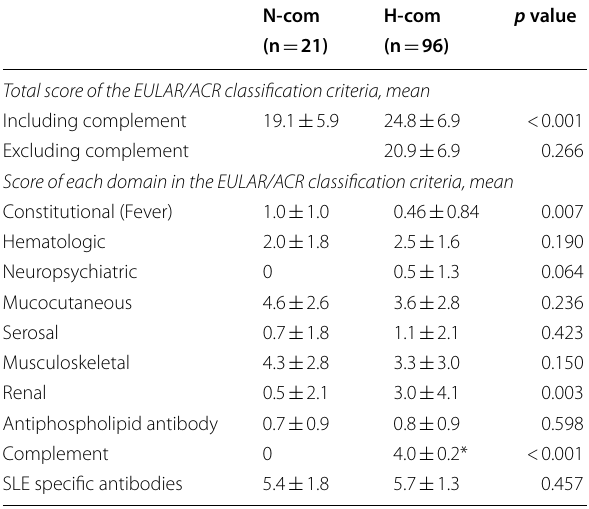
Table 4 Scores in the EULAR/ACR classification criteria between SLE patients with normal and low serum complement